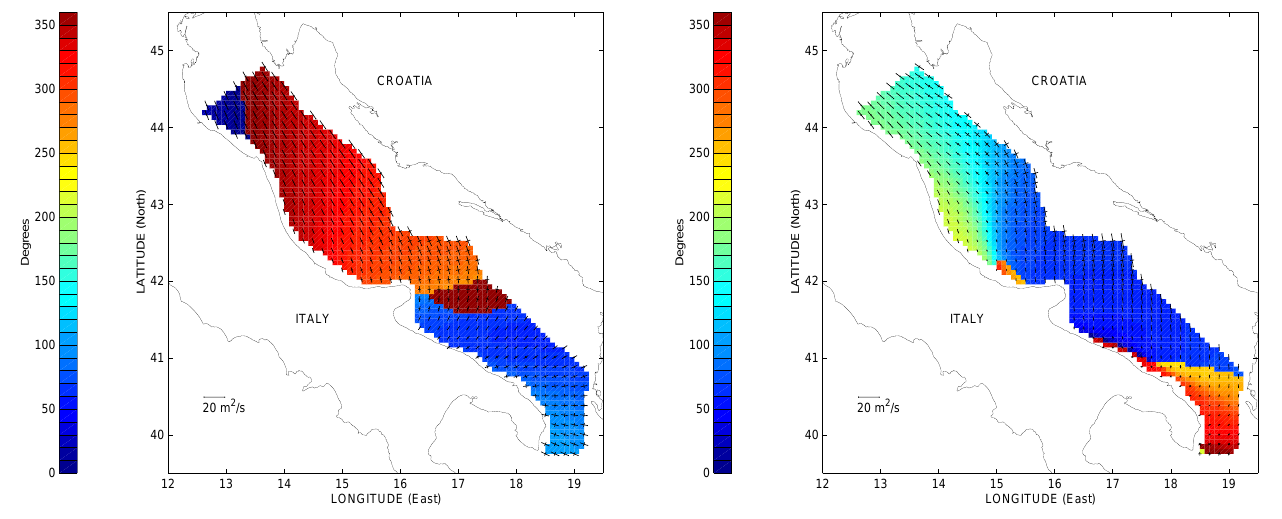
Fig. 6. M2 phase and ellipses calculated from vertically averaged ADCP data for the summer season. Phase corresponds to times when the semi-major axis is in the first or the fourth trigonometric quadrant.